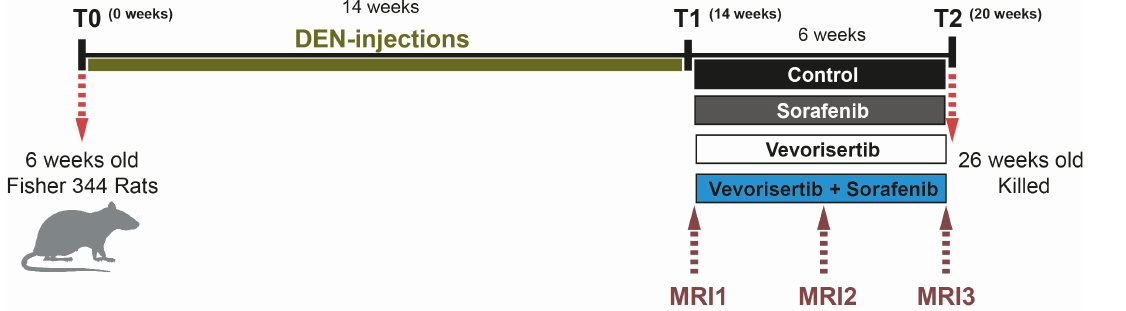
Table 1. Clinical and biological analysis. Control